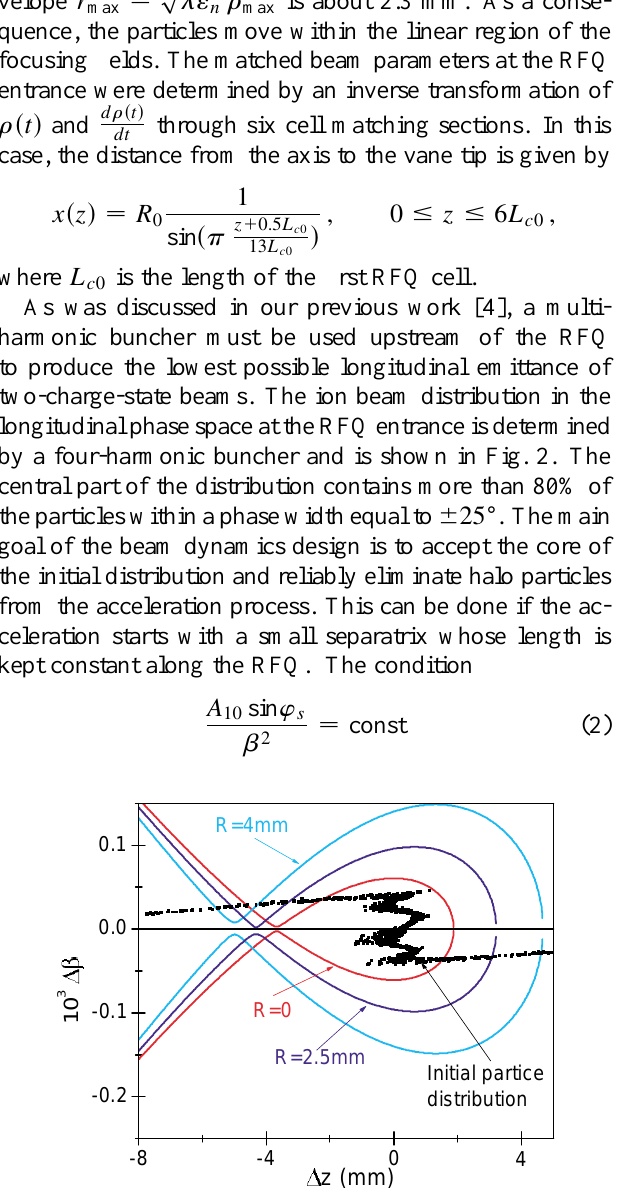
velope r max (cid:1)